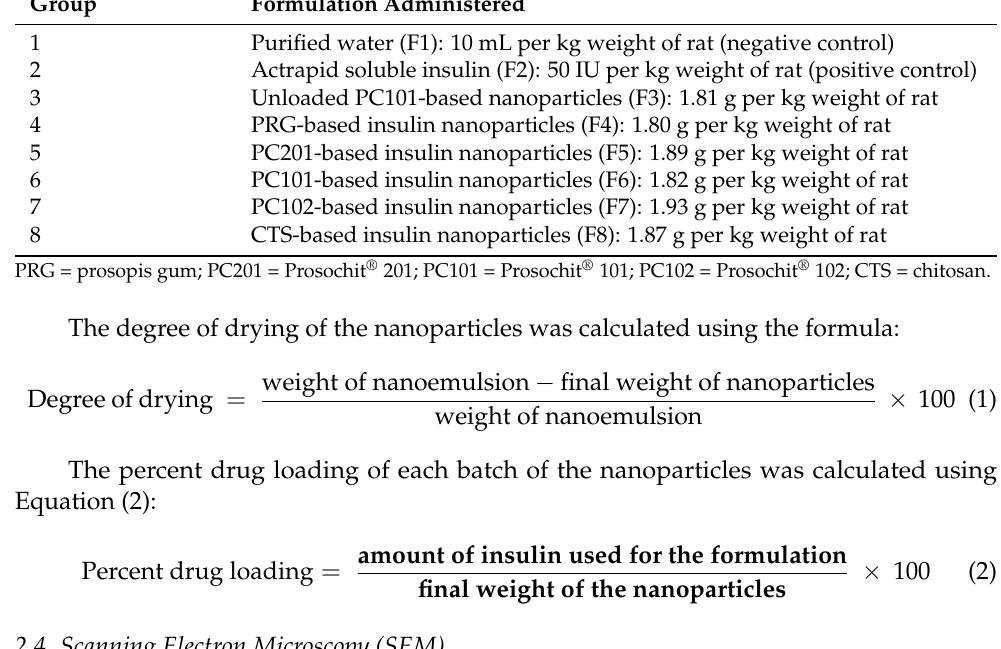
Table 1. Formulations administered to the different groups of rats. Group Formulation